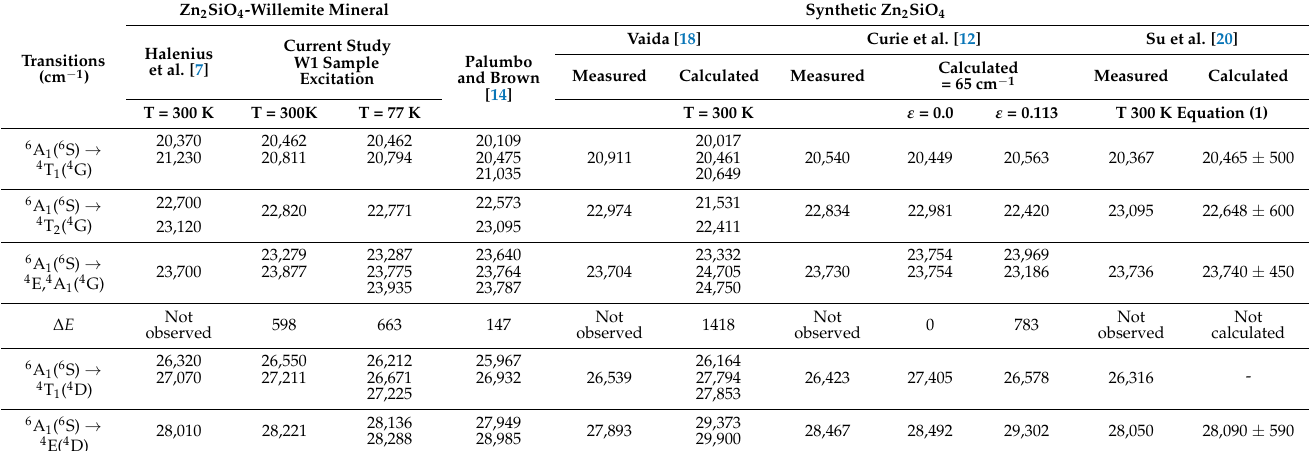
Table 7. The measured and calculated Mn 2+ -bands for natural and synthetic